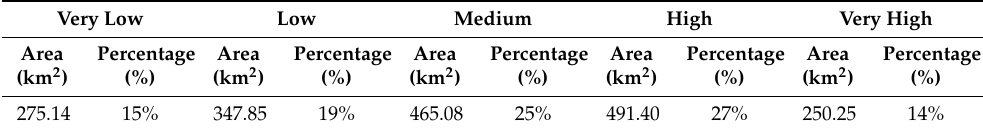
Table 5. Classes according to susceptibility to